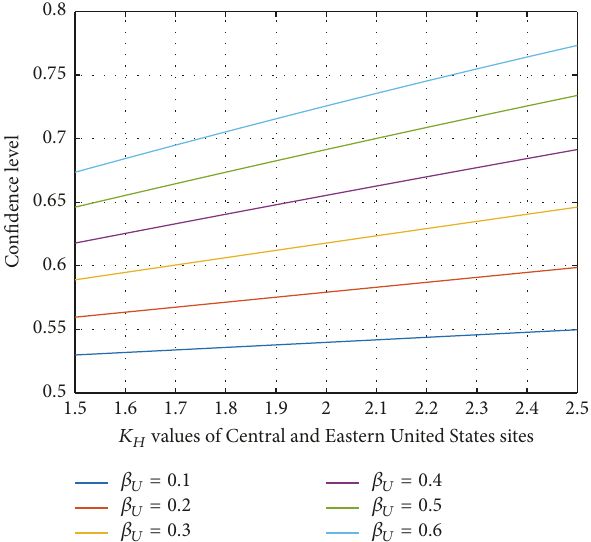
Figure 2: Confidence levels of mean seismic risk probability model used in Central and Eastern United States